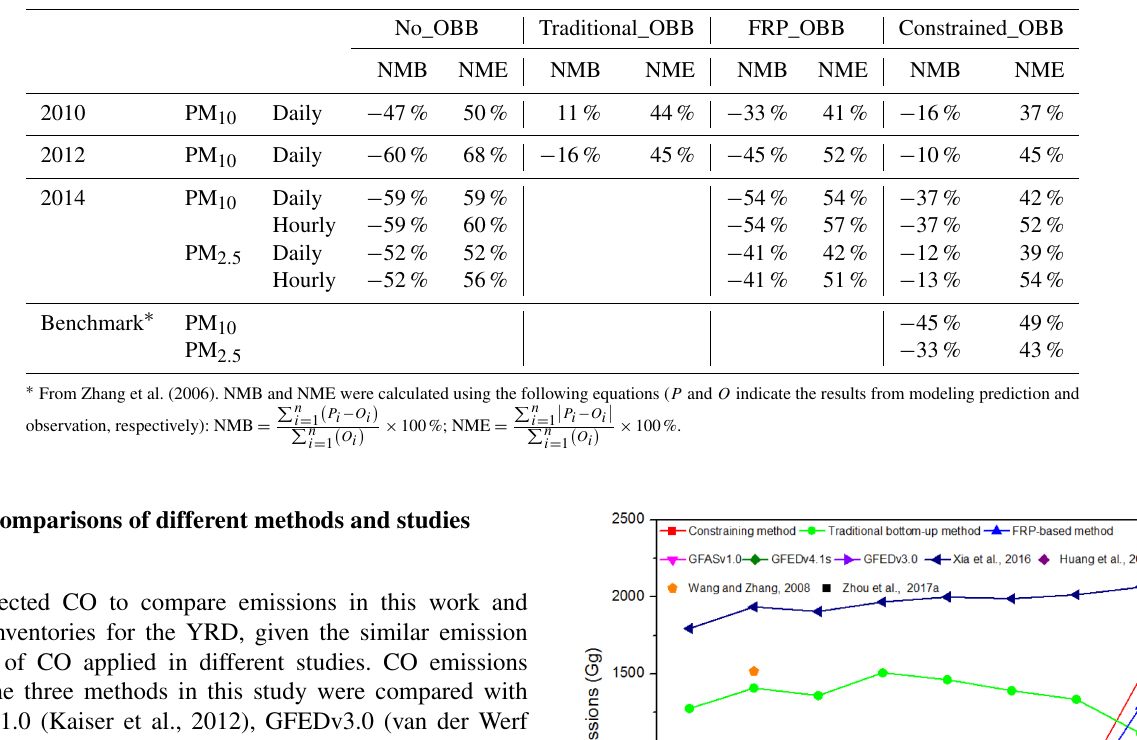
Table 2. Model performance statistics for concentrations of PM 2 . 5 and PM 10 from observation and CMAQ simulation without OBB emis- sions (No_OBB) and with OBB emissions based on traditional bottom-up (Traditional_OBB), FRP-based (FRP_OBB) and constraining methods (Constrained_OBB) for the three OBB events of June 2010, 2012 and 2014.